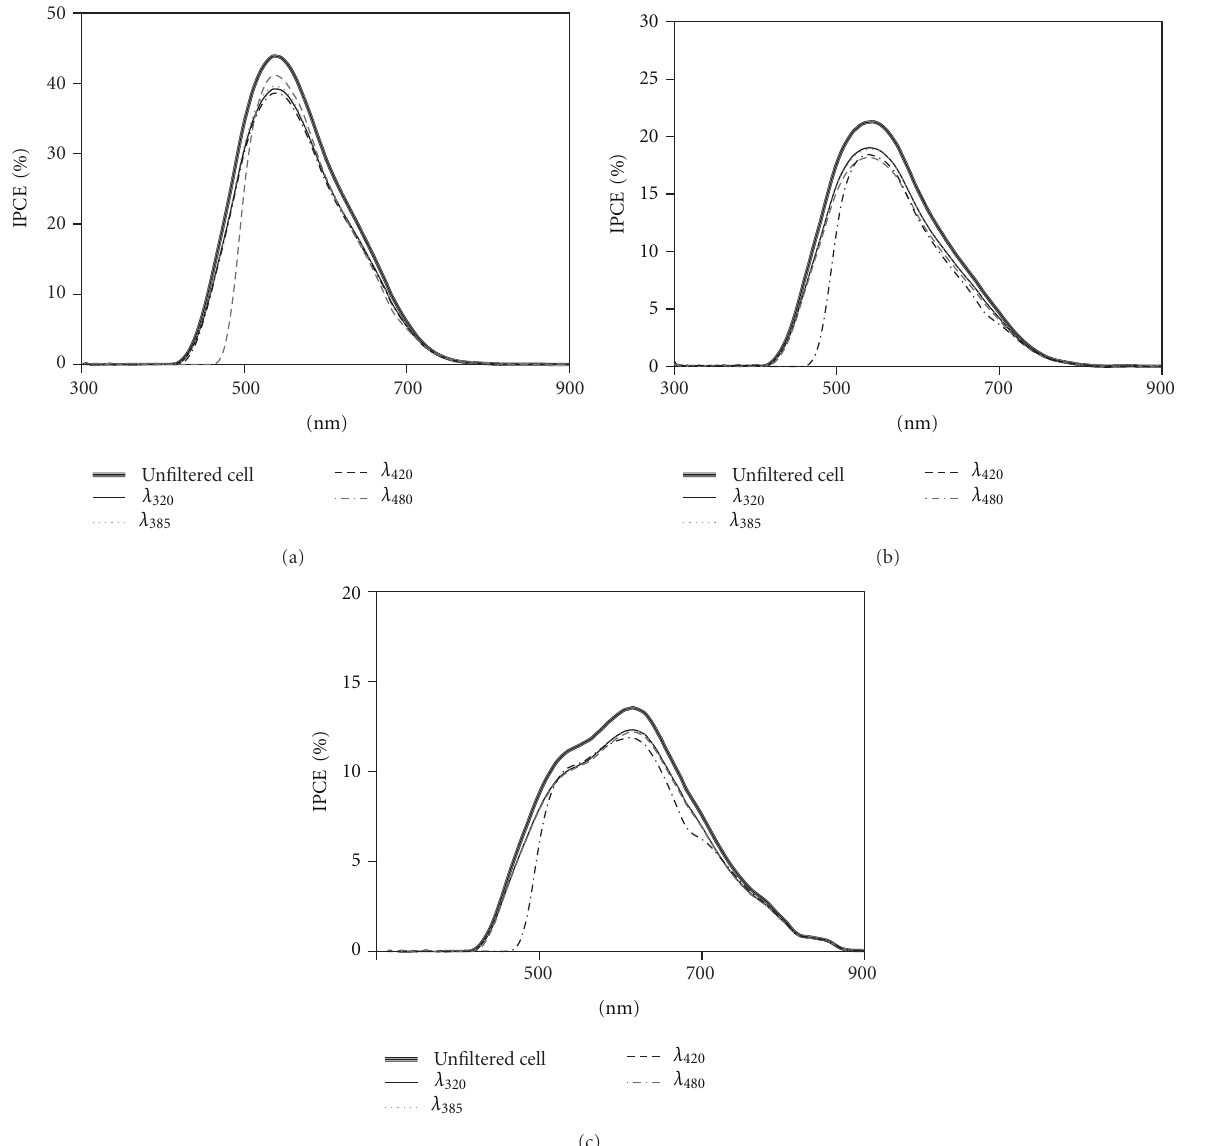
Figure 8: The e ff ects of filtering upon the IPCEs of DSCs made with three di ff erent dyes, (a) N719, (b) Z907, and (c) N749, and measured under forward